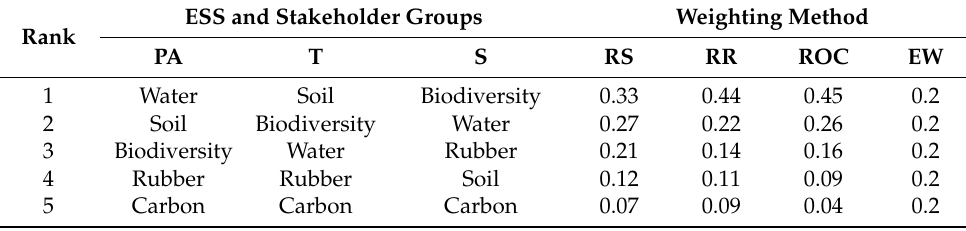
Table 2. Ranking of each ecosystem service based on feedback of three stakeholder groups concerning their importance in descending order and their corresponding weight factors used for the ecosystem service evaluation. ESS and Stakeholder Groups Weighting Rank